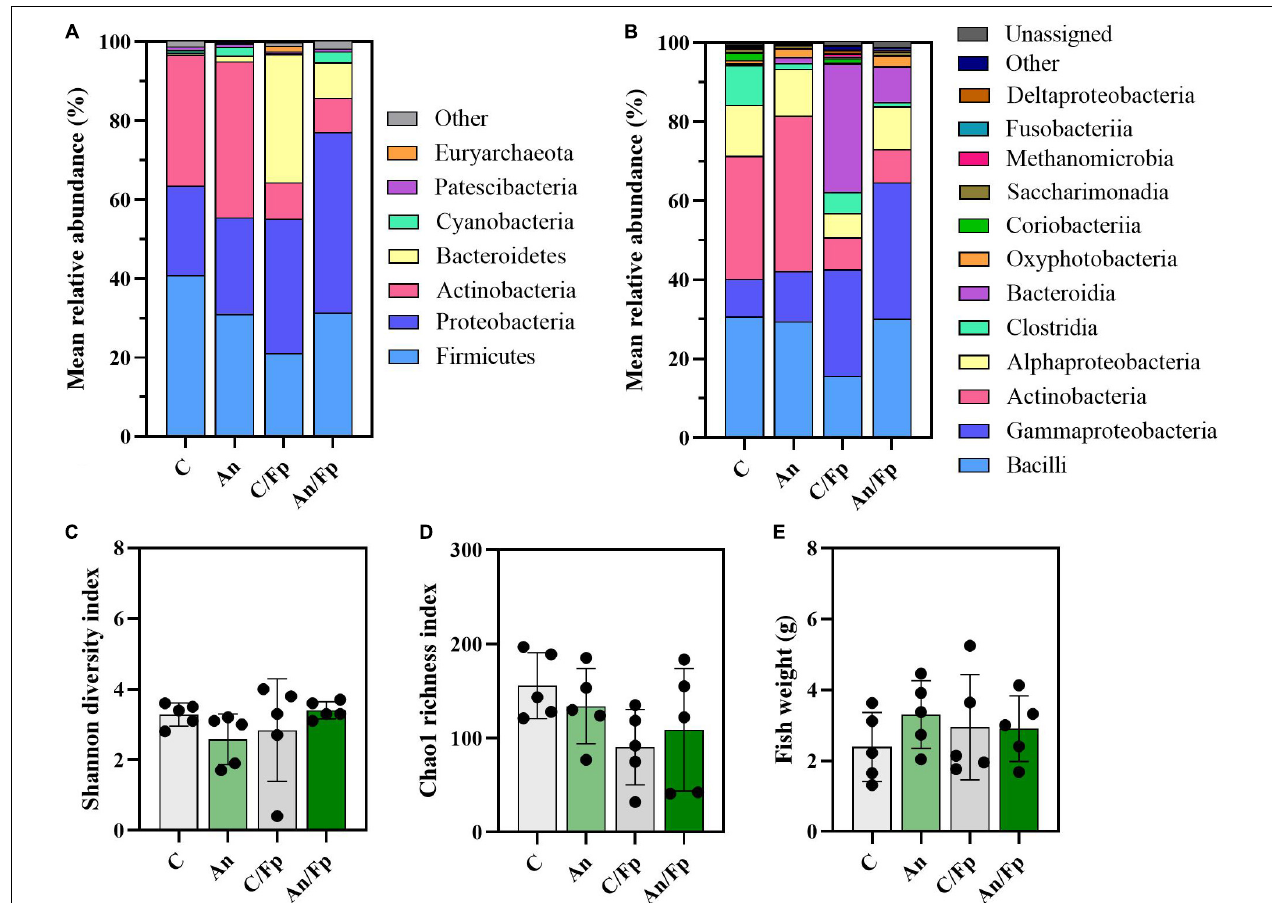
FIGURE 8 | Microbial community (8 dpi). Characterization of mean relative abundance at phylum (A) and class (B) level, Shannon diversity index (C) , Chao1 richness index (D) , and fish weight (E) . Values represent the mean of five samples. In (C–E) , error bars represent the standard deviation. Shannon diversity index values are based on 10,000 reads per sample. C, control feed group; An, antibiotic feed group; C/Fp, control feed group + F. psychrophilum ; An/Fp, antibiotic feed group + F. psychrophilum .